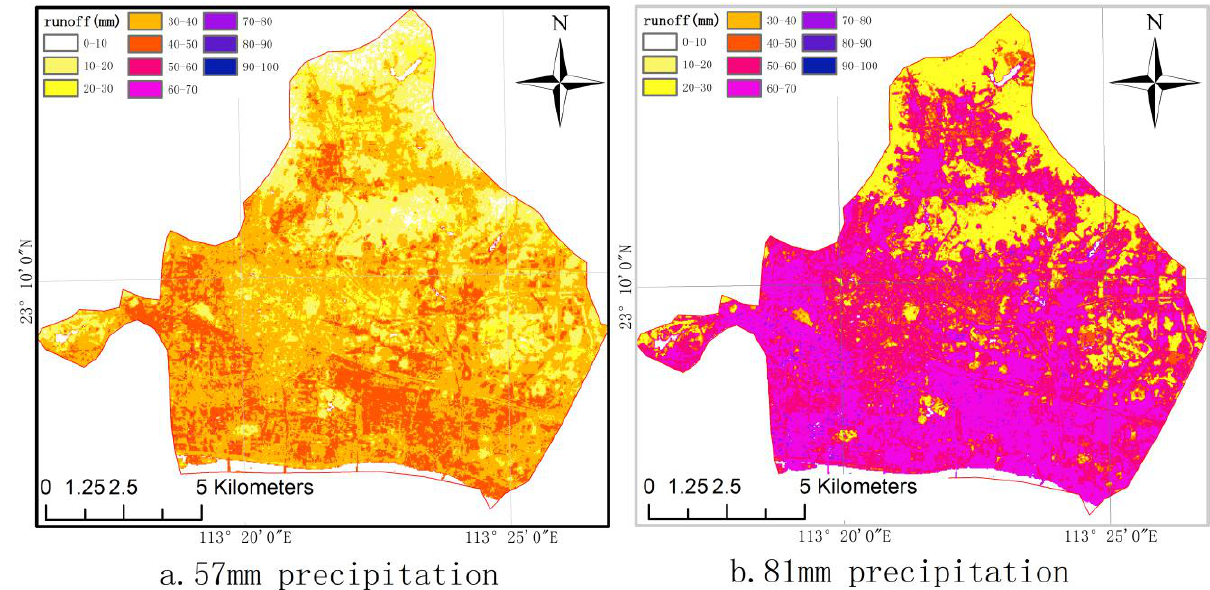
Figure 5. Simulated runoff under 57 mm and 81 mm